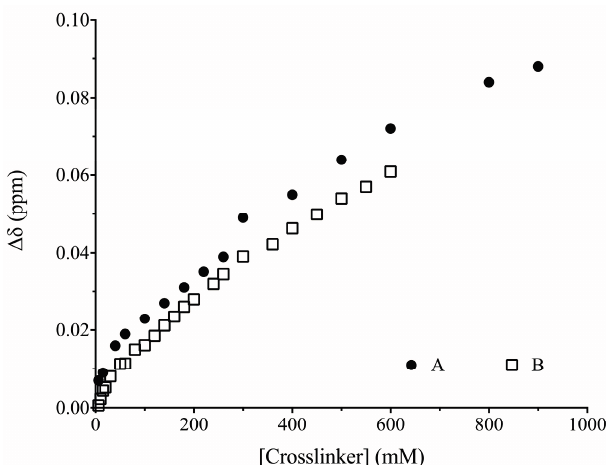
Figure 2. 1 H-NMR titration plots where constant concentrations of propranolol and methacrylic acid were titrated with increasing amounts of crosslinking monomer, in (A) TRIM and in (B) EGDMA. The isopropyl methyl resonances of ( S )-propranolol were studied (Figures 1 and